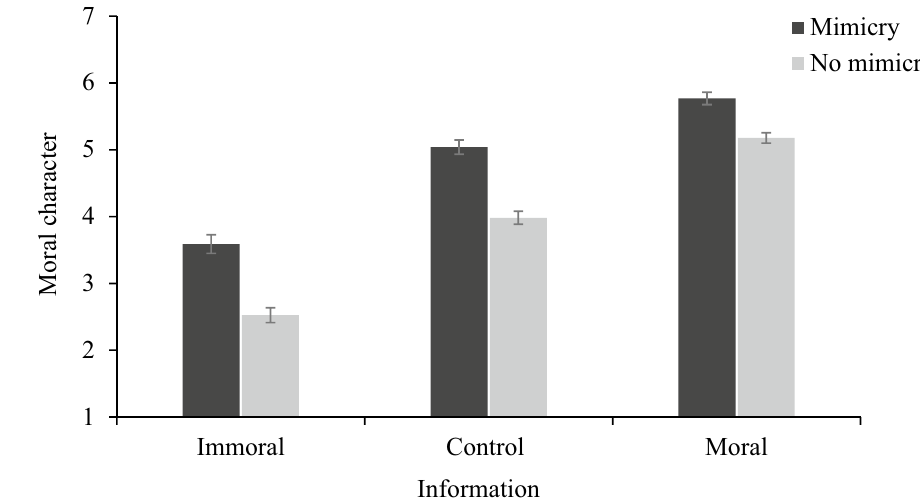
Figure 1. Mean moral character judgments as a function of the moral information and mimicry manipulation. Higher scores indicate more positive assessments of moral character. The error bars represent one standard